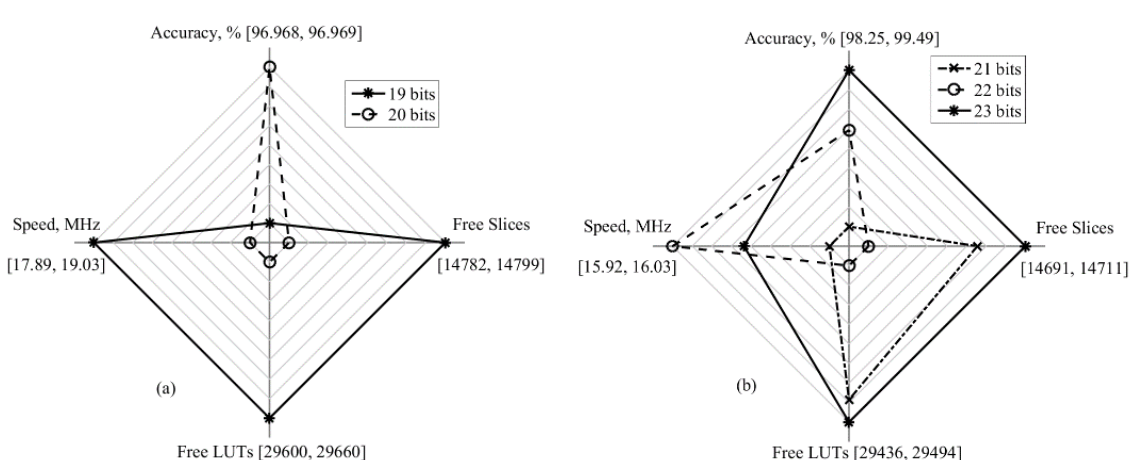
Fig. 8. Comparison of FPGA resources used and calculation accuracy when implementations of IVGTT MP system with different number of bits for the fractional part of binary word result in the same number of 18 (a) or 22 (b) DSP cells used.